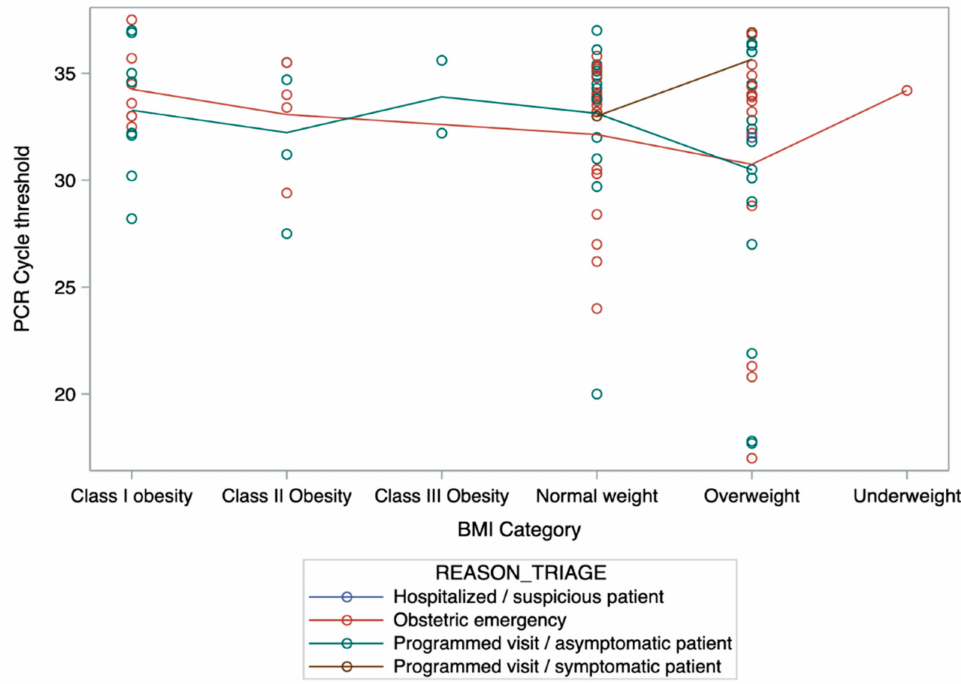
Figure 3. Two-way ANOVA C T distribution between BMI categories. Women with overweight tended to have lower (non-significant) C T